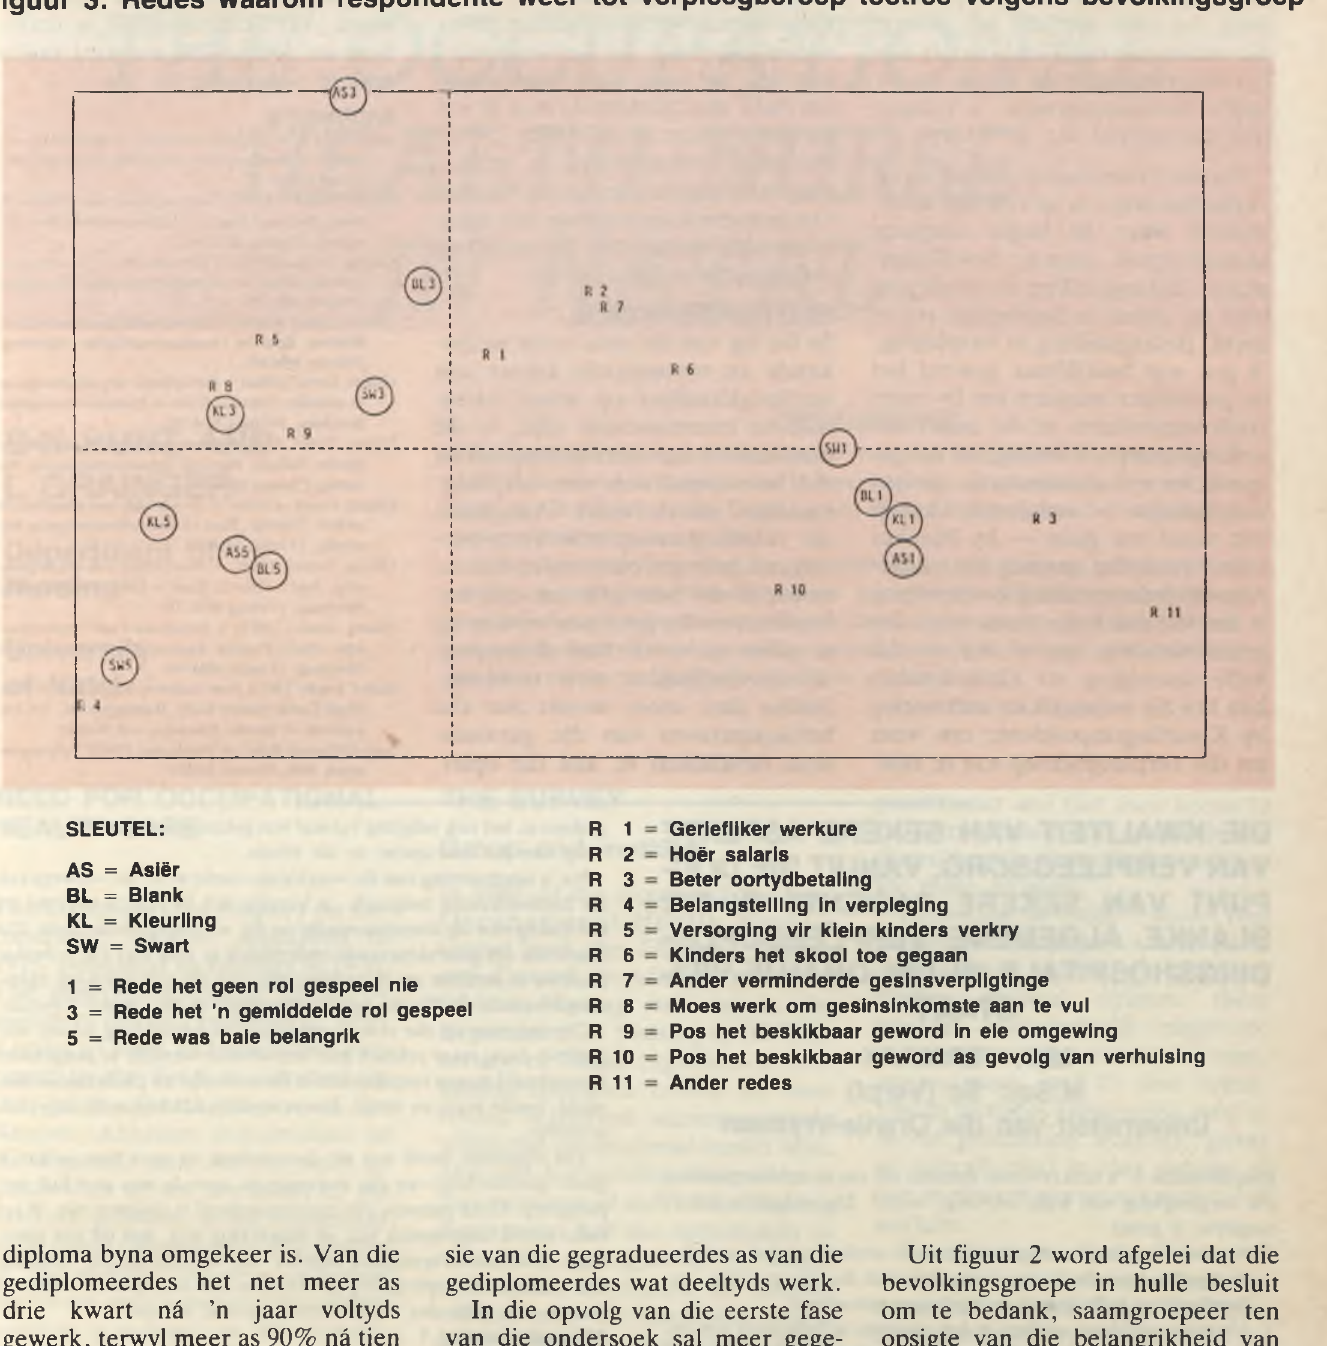
Figuur 3: Redes waarom respondente weer tot verpleegberoep toetree volgens